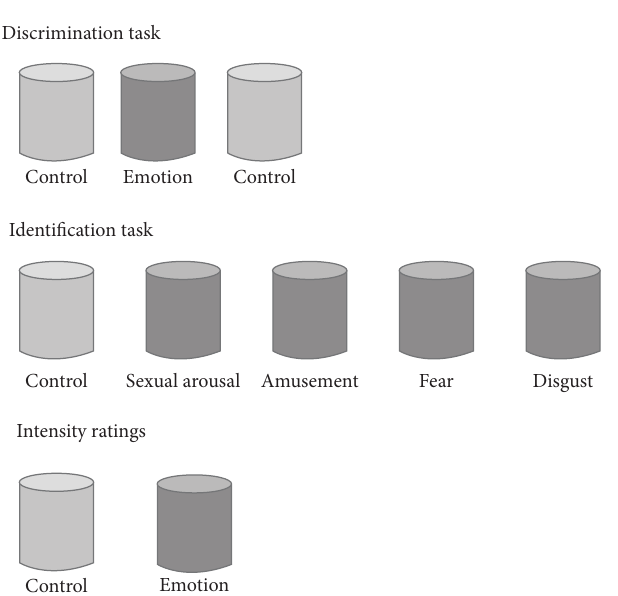
Figure 1: Graphical representation of the different tasks. The par- ticipants started with a detection task, followed by an identification task. Lastly, they had to rate the intensity of each emotion and the controls. The bottles with light shades represent the controls, whereas the darker shaded bottles represent the emotions.